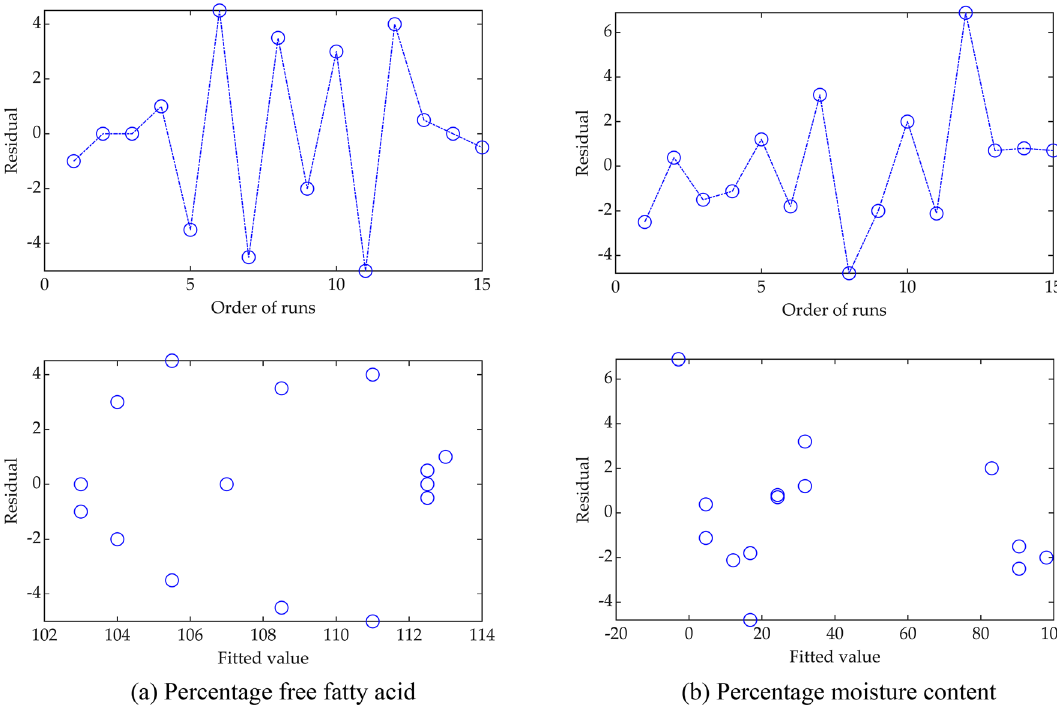
Figure 1. Residual plot of the statistical multi-regression model.